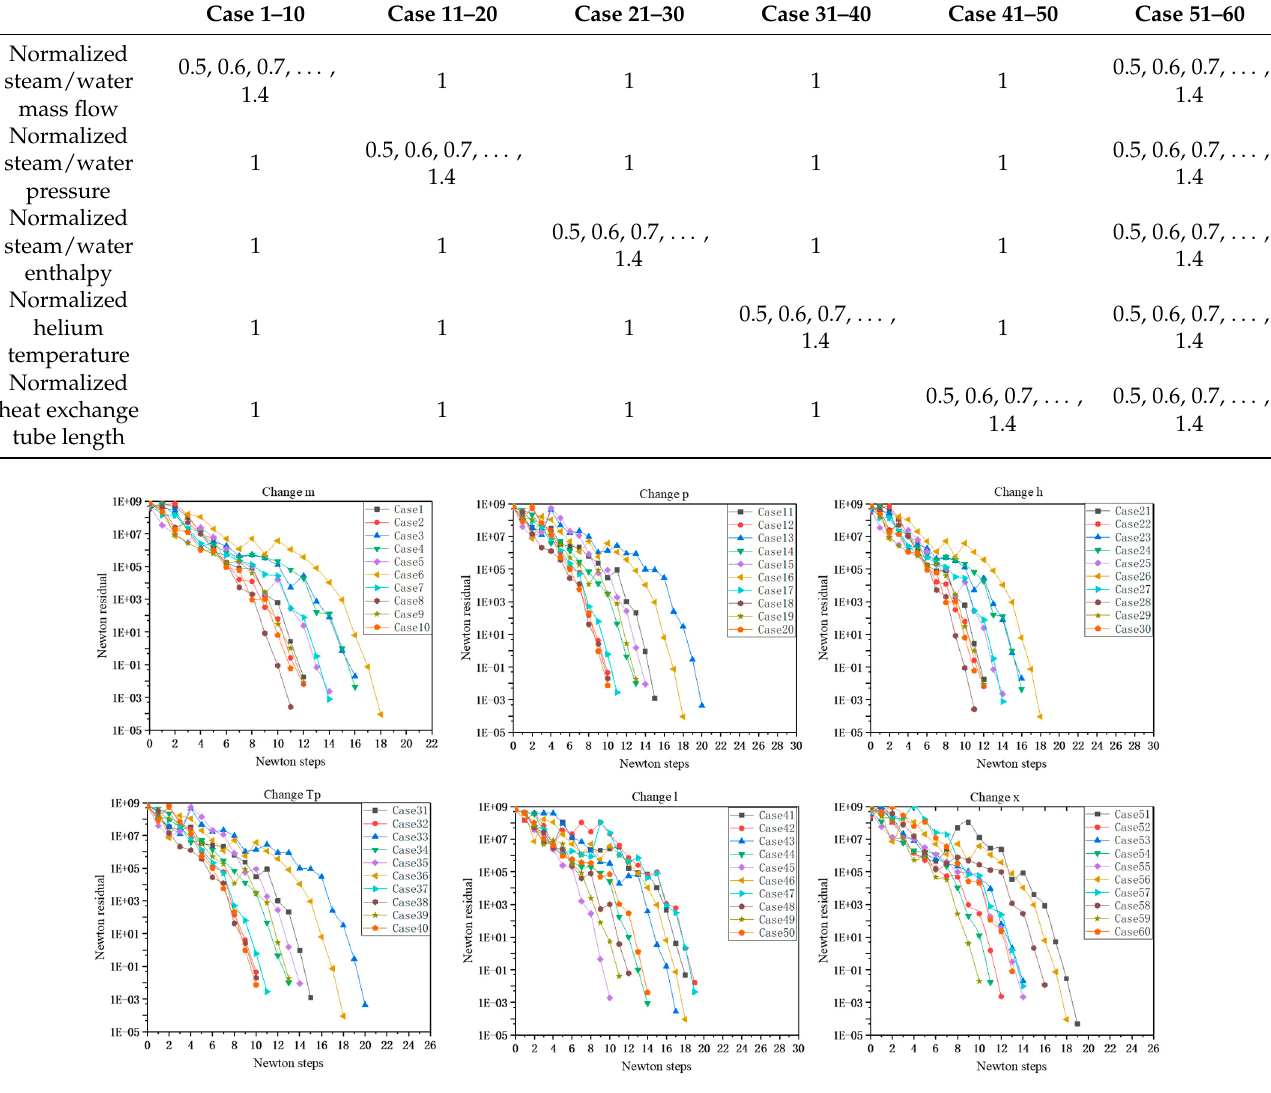
Figure 5. Newton convergence behavior under different initial values. Table 4. Average Newton iterations.